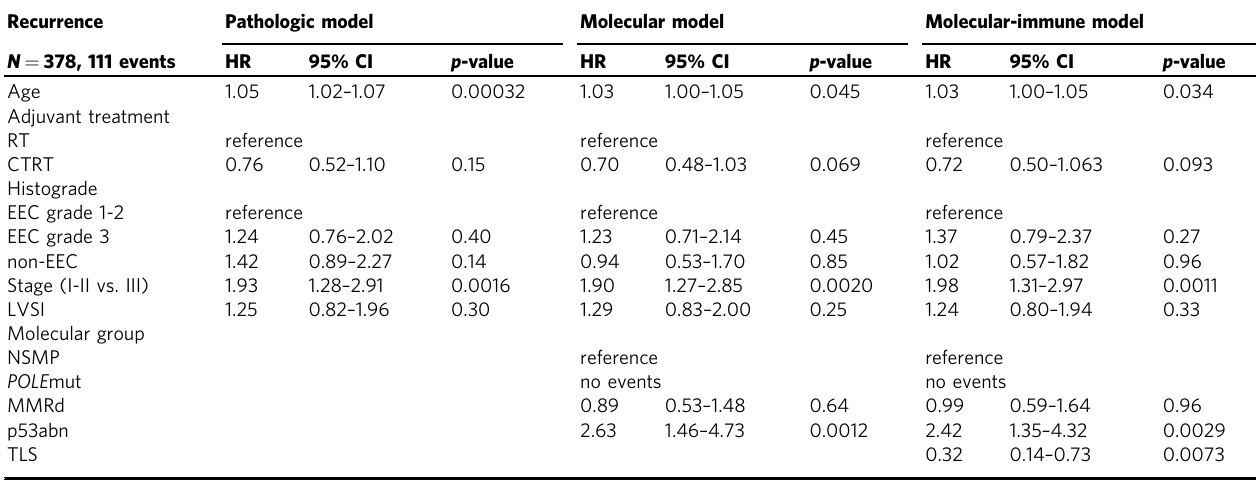
Table 1 Prognostic factors for recurrence in high-risk endometrial cancer.